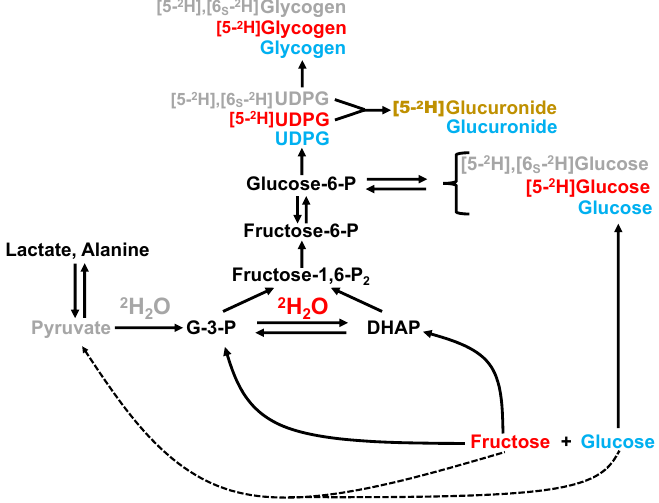
Figure 1. Metabolic scheme relating 2 H-enrichment in positions 5 and 6 of circulating glucose, UDP-glucose (UDPG), glucuronide and hepatic glycogen with the utilization of fructose and glucose from the test meal. On conversion of fructose to dihydroxyacetone phosphate (DHAP) and glyceraldehyde-3-phosphate (G-3-P), hydrogen exchange mediated by triose phosphate isomerase incorporates 2 H from 2 H 2 O into position 5 of glucose and glycogen pathway products, represented in red. In addition, a small amount of fructose may be converted to pyruvate via glycolysis before being incorporated into glucose and glycogen via gluconeogenesis. This possibility also holds for dietary glucose. Passage of these and other gluconeogenic precursors, including lactate and alanine, will generate glucose and glycogen pathway products enriched in both positions 5 and 6 S (represented in grey). Glucose from the meal that is directly absorbed will not be enriched in position 5 or 6 nor will these positions become enriched during subsequent conversion to UDPG, glucuronide and glycogen via the direct pathway (represented in blue). Formation of glucuronide from UDPG results in the loss of the position 6 hydrogens, hence this metabolite informs enrichment of position 5 from all gluconeogenic precursors including fructose (represented in brown). Some metabolic intermediates have been omitted for